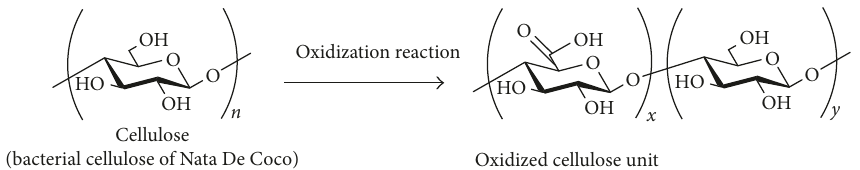
Figure 1: Oxidation reaction of